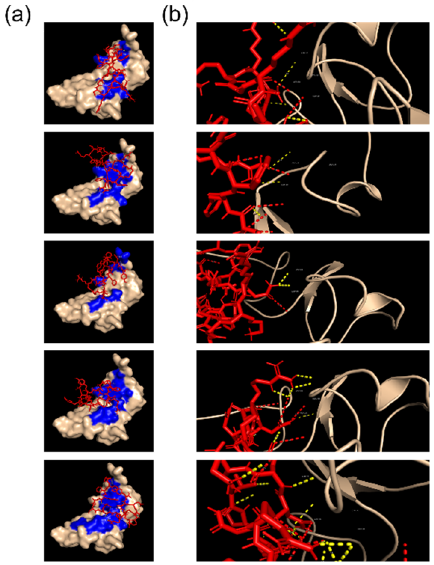
Figure 2. Simulation of Angioepep-2/CR56 binding: molecular docking results; ( a ) 3D representation of angiopep-2 binding mode on CR56 (in blue); ( b ) details of Angiopep-2/CR56 binding (dotted line in yellow represents pi interaction, in red electrostatic clashes). Table 1. Binding of angiopep-2 to CR56 of LRP-1: characteristic binding energy and classification of receptor residues involved in the binding.